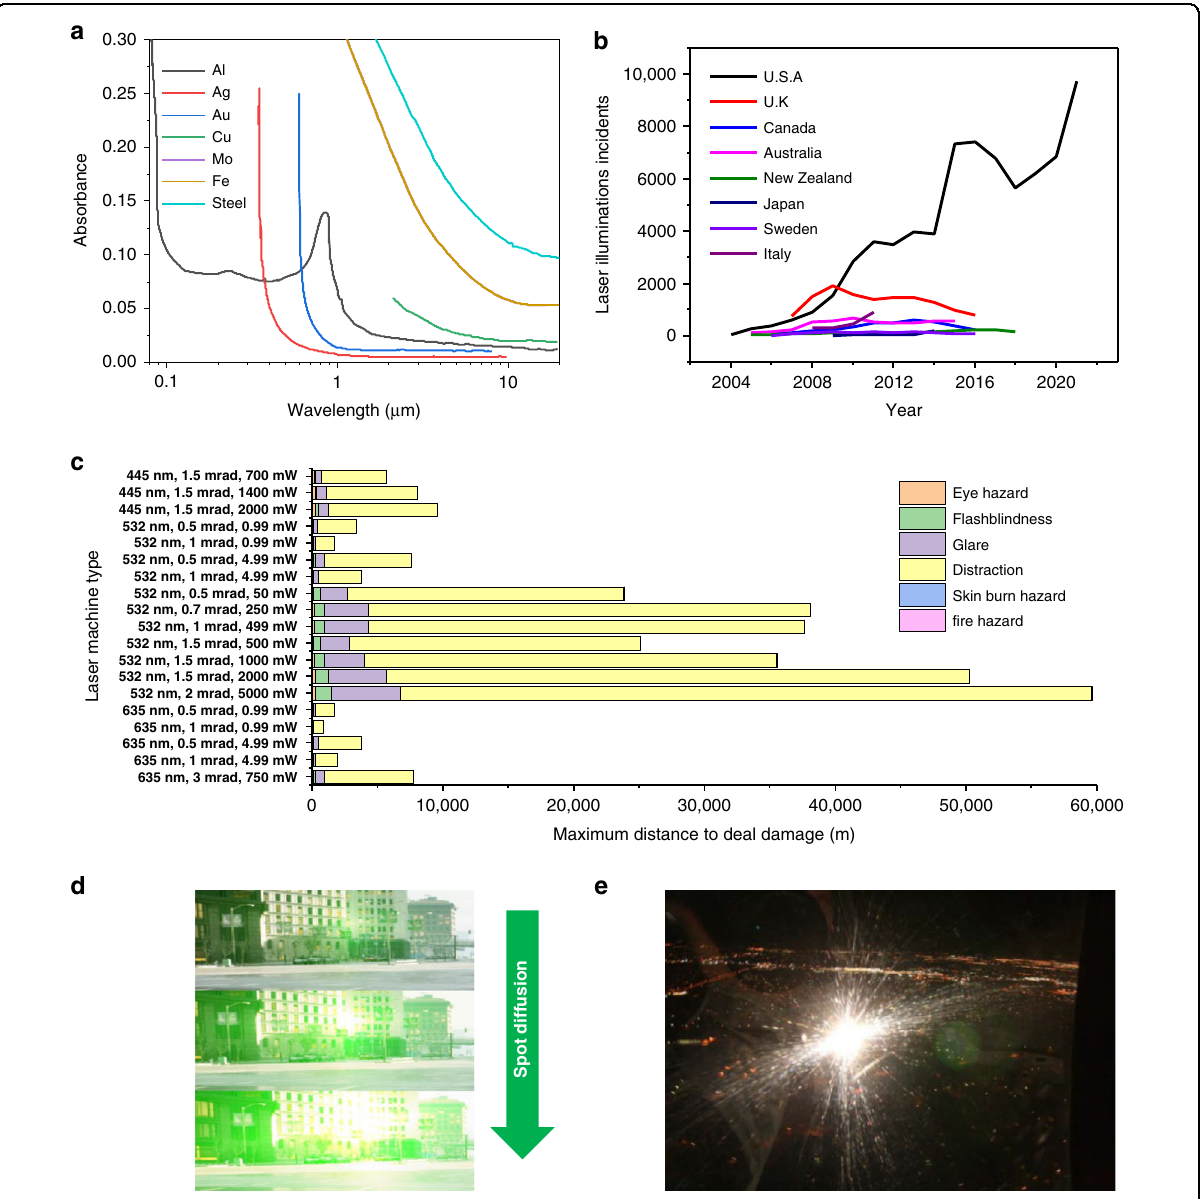
Fig. 4 Characteristics of arti fi cial light and its hazards. a Common lasers and their luminous bands. b Laser illuminations of airplanes on a global and yearly basis. c Relationship between the damage caused by different types of lasers and distance. d Visual disturbance caused by glare fi elds of different radii. e High-intensity lighting technology that creates dazzling light. Reproduced with permission from ref. 63 . Copyright 2009,